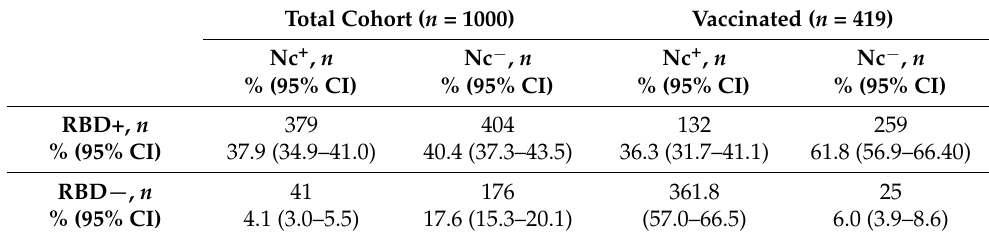
Table 2. Structure of antibody seroprevalence in the fifth